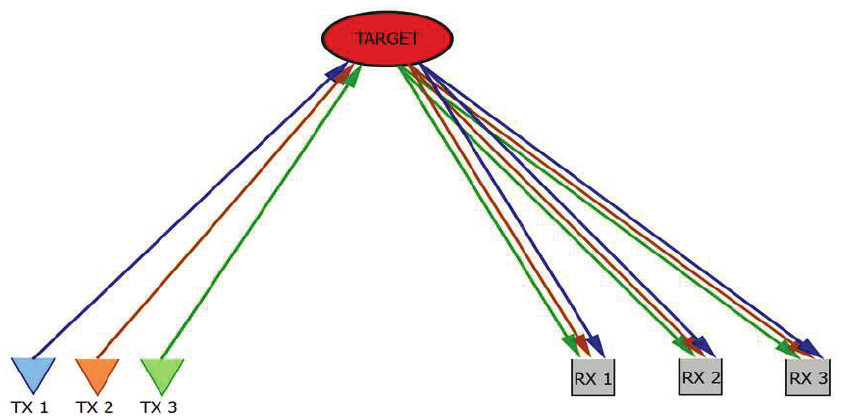
Fig. 1 . An example of building a MIMO radar